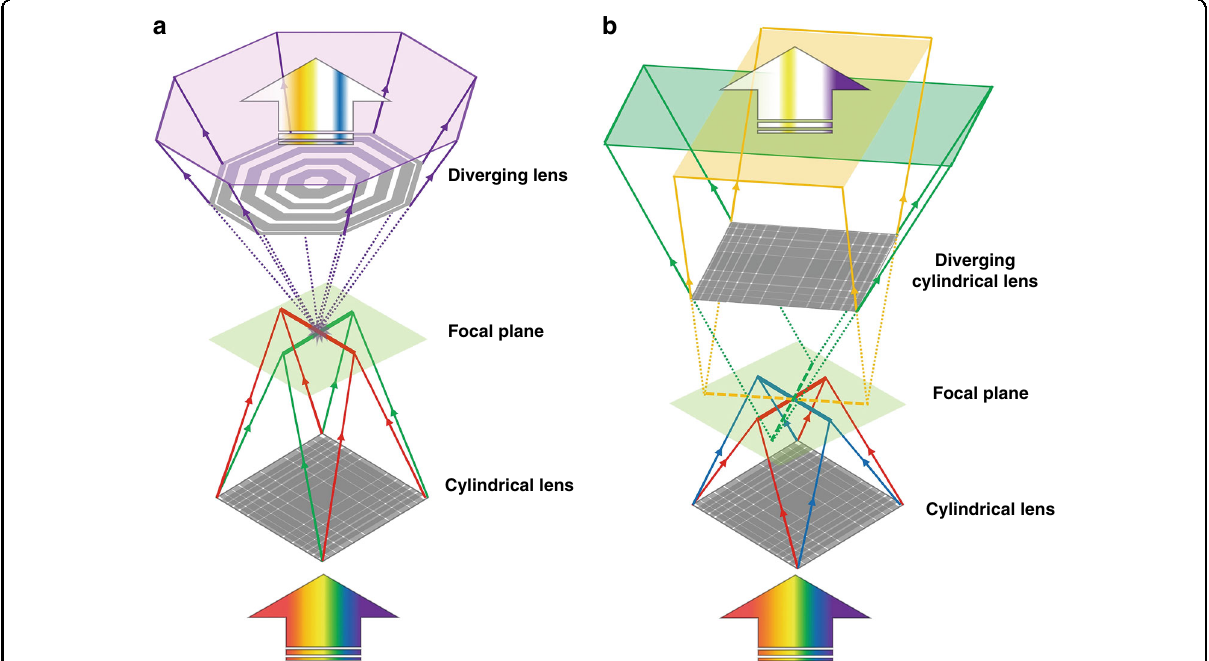
Fig. 1 Schematic diagram of multifunctional platform of nonlocal metasurfaces. a Schematic of a three-function doublet composed of a single- function diverging metalens and a dual-function converging cylindrical metalens. b Schematic illustrating a four-function doublet composed of a dual-function diverging cylindrical metalenses and a dual-function converging cylindrical